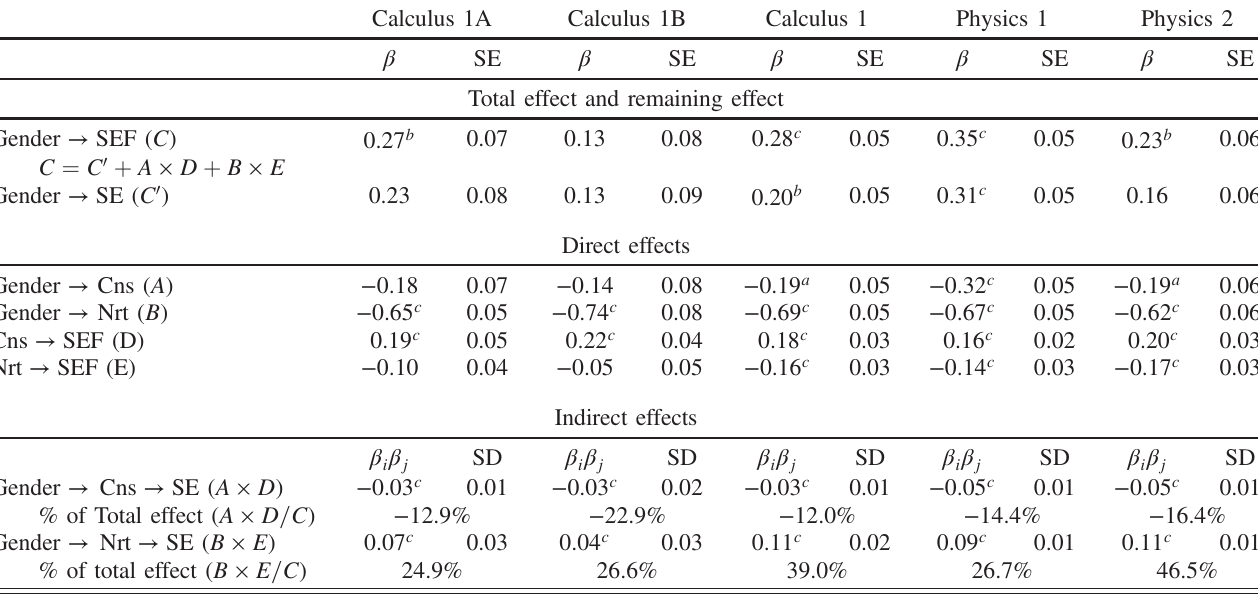
TABLE II. The mediation by neuroticism and conscientiousness of the relation of gender to self-efficacy. The regression coefficient β and its standard error (SE) are presented. Women are coded as zero, men as one. For indirect effects, the product of the path coefficients β β is presented and the standard deviation (SD) of the product. Conscientiousness is abbreviated Cns, neuroticism Nrt, and self- i j efficacy SEF. Note that “ a ” denotes p < 0 . 05 , “ b ” p < 0 . 01 , and “ c ” p < 0 . 001 . A Bonferroni correction was applied to the significance levels.